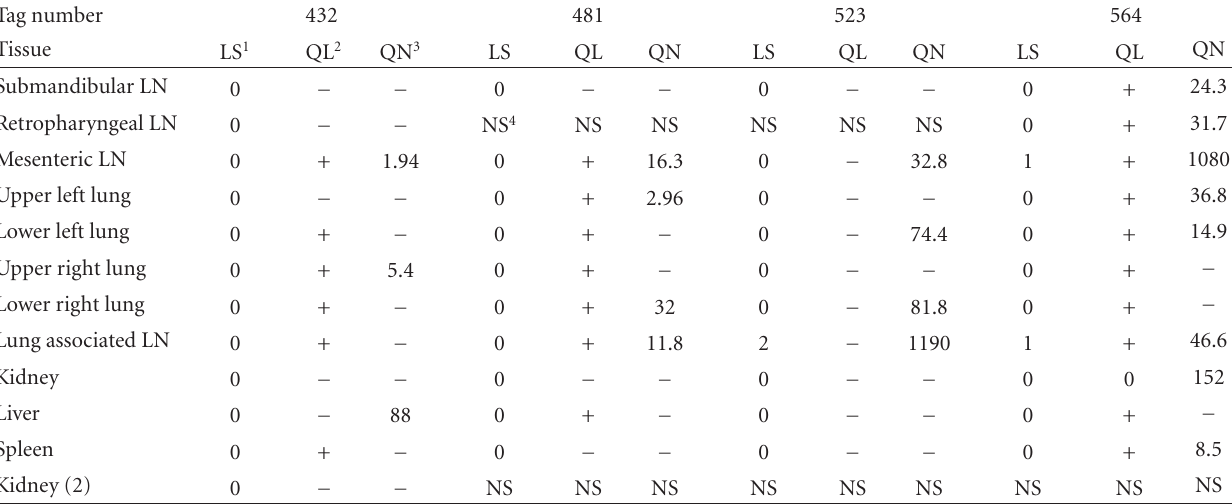
Table 1: Isolation of M. bovis from a range of tissues taken from 4 ferrets infected with 0 . 8 × 10 2 CFU and examined postmortem at 8 weeks post infection.